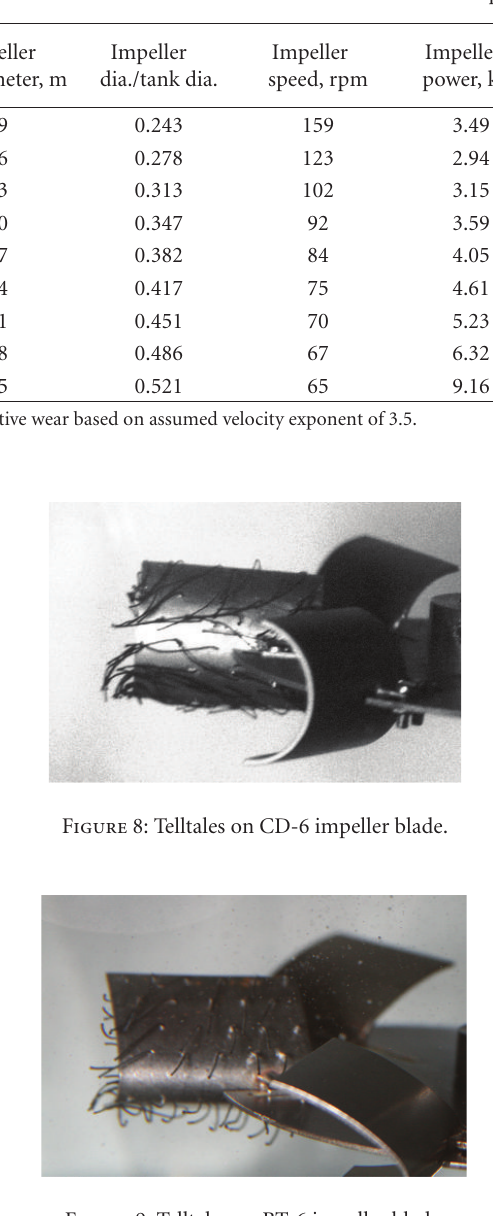
Figure 9: Telltales on BT-6 impeller